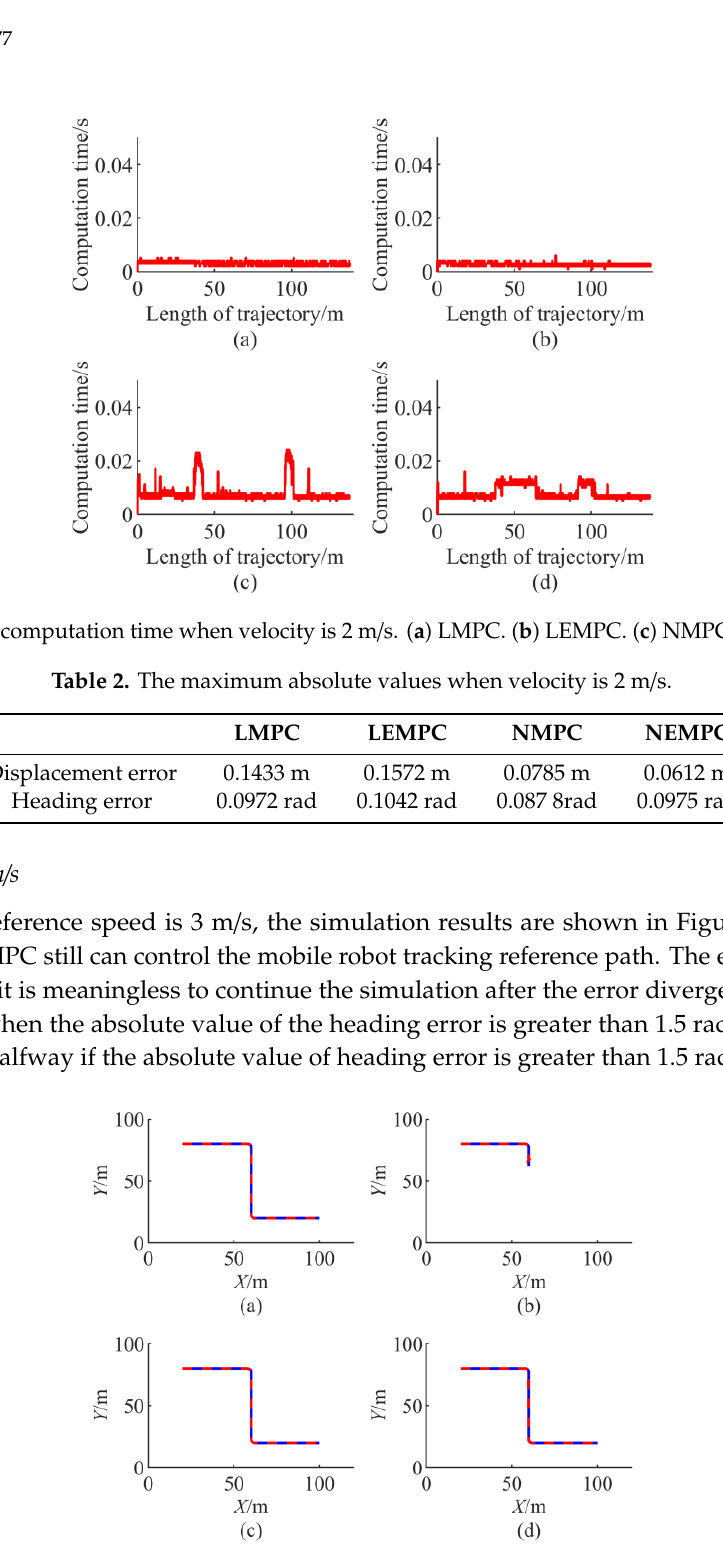
Figure 8. The velocity when velocity is 3 m/s. ( a ) LMPC. ( b ) LEMPC. ( c ) NMPC. ( d ) NEMPC. The maximum absolute values are shown in Table 3. The error of all MPC-based controllers increases with respect to that when the reference velocity is 2 m/s. The control inputs of the NMPC are the smoothest. Table 3. The maximum absolute values when velocity is 3 m/s. LMPC